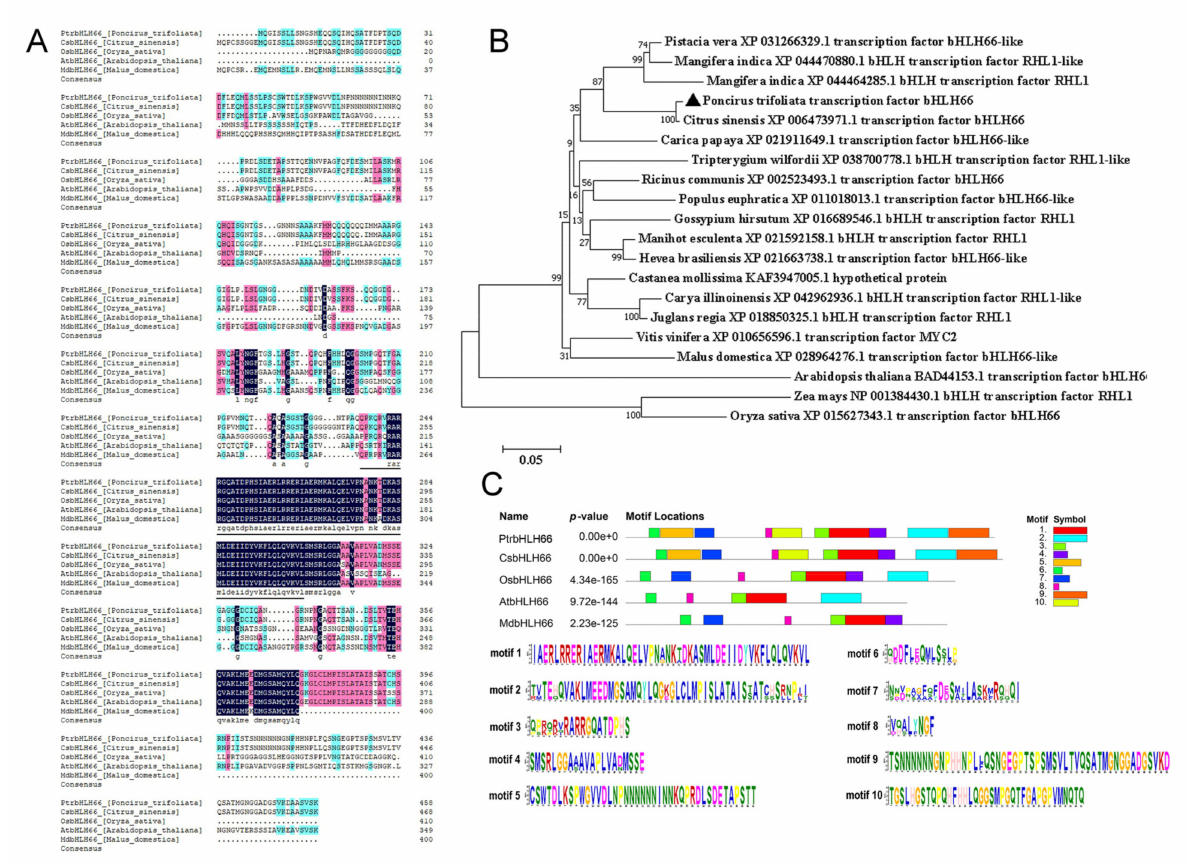
Figure 1. Structural and phylogenetic analysis of the PtrbHLH66 protein. ( A ) Multiple sequence alignment of PtrbHLH66 with its homologous proteins from different plant species, including Citrus sinensis CsbHLH66 (GenBank accession number: XP_006473971.1), Oryza sativa OsbHLH66 (XP_015627343.1), Arabidopsis thaliana AtbHLH66 (BAD44153.1) and Malus domestica MdbHLH66 (XP_028964276.1). The bHLH domain is marked with black solid bars. ( B ) Phylogenetic analysis of PtrbHLH66 and its homologous proteins from different plant species. ( C ) Analysis of the conserved motifs of PtrbHLH66 and its homologous proteins. Ten different motifs were identified and indicated by different colors. The nucleotide sequence of each conserved domain was also